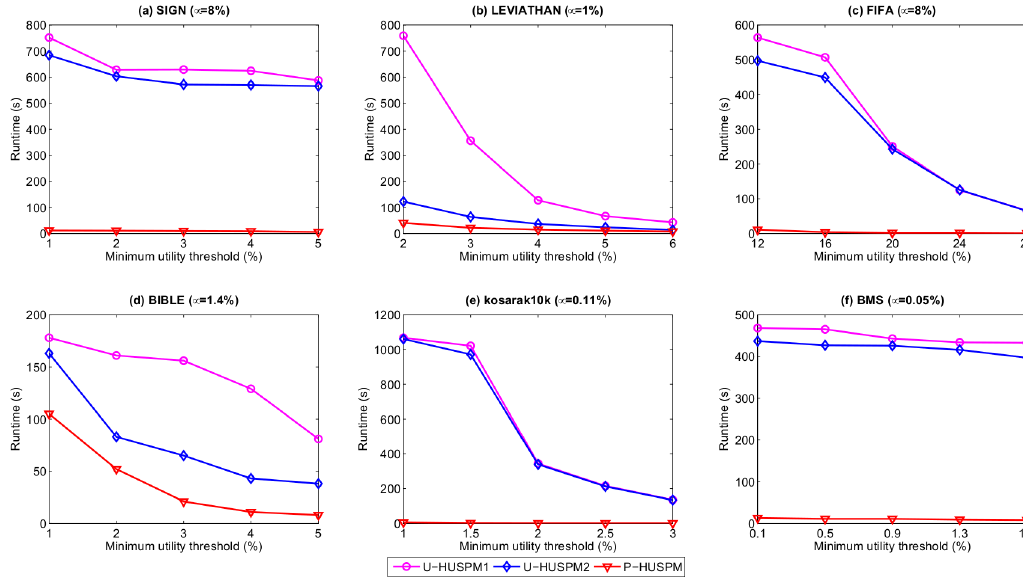
Fig 1. Runtimes when μ is fixed and ε is